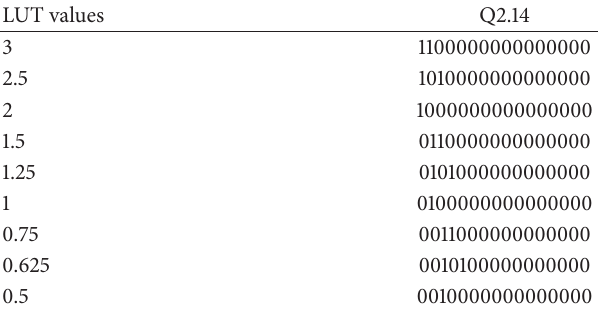
Table 1: A section of input values corresponding to values stored in LUT.